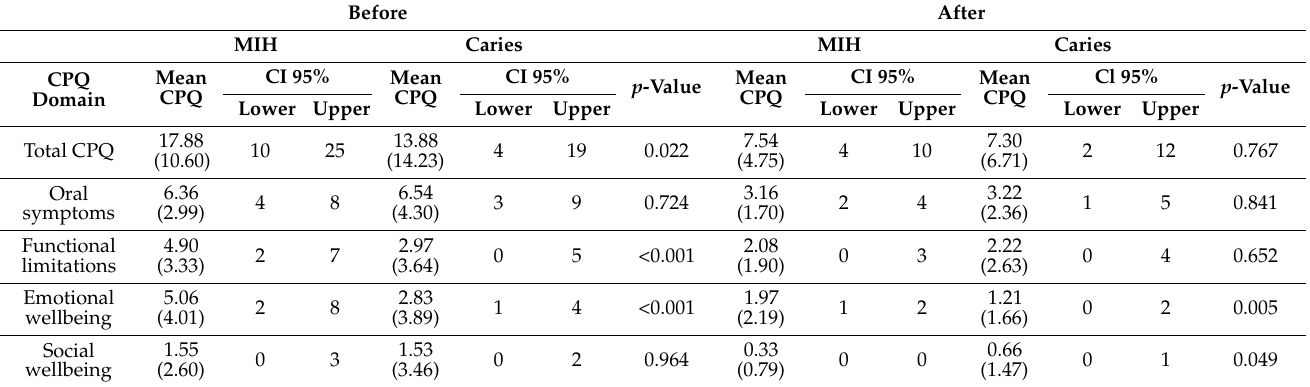
Table 3. Comparison of the Means and Confidence Intervals for CPQ Subscale Scores for the MIH and Caries Group Before and After